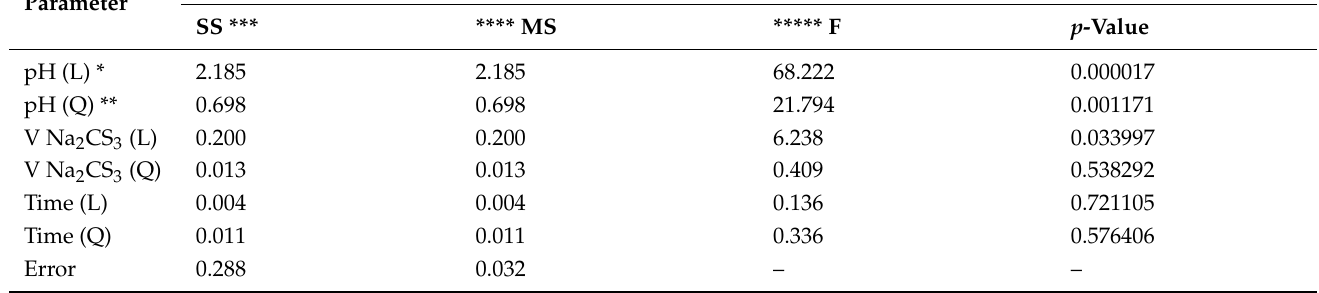
Table 6. Analysis of the experiments’ findings by Statistica 13—verification of the adequacy of the model by ANOVA.